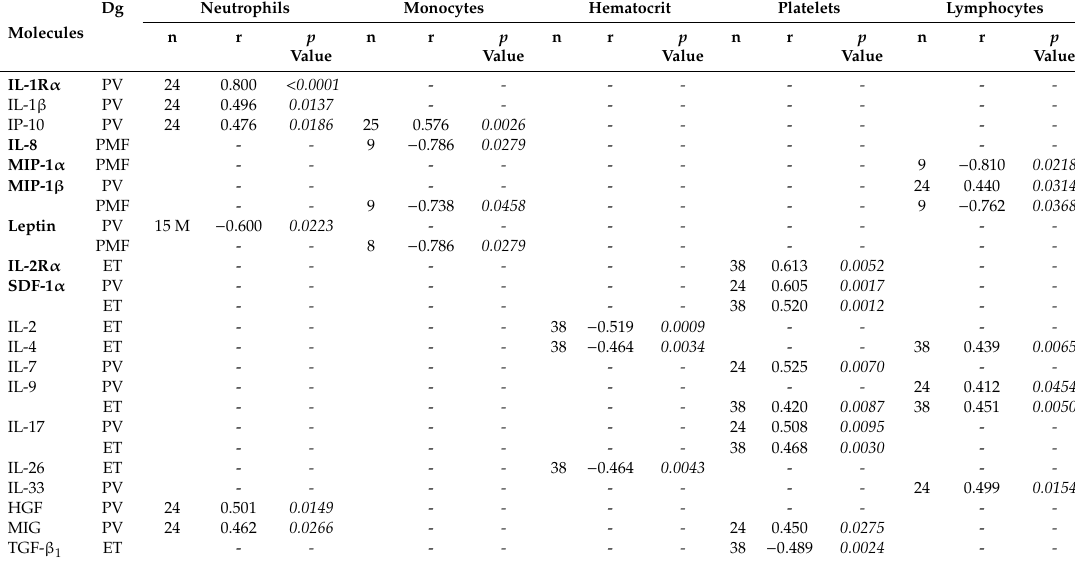
Table 3. Correlations between cytokine levels and blood counts in PV, ET and